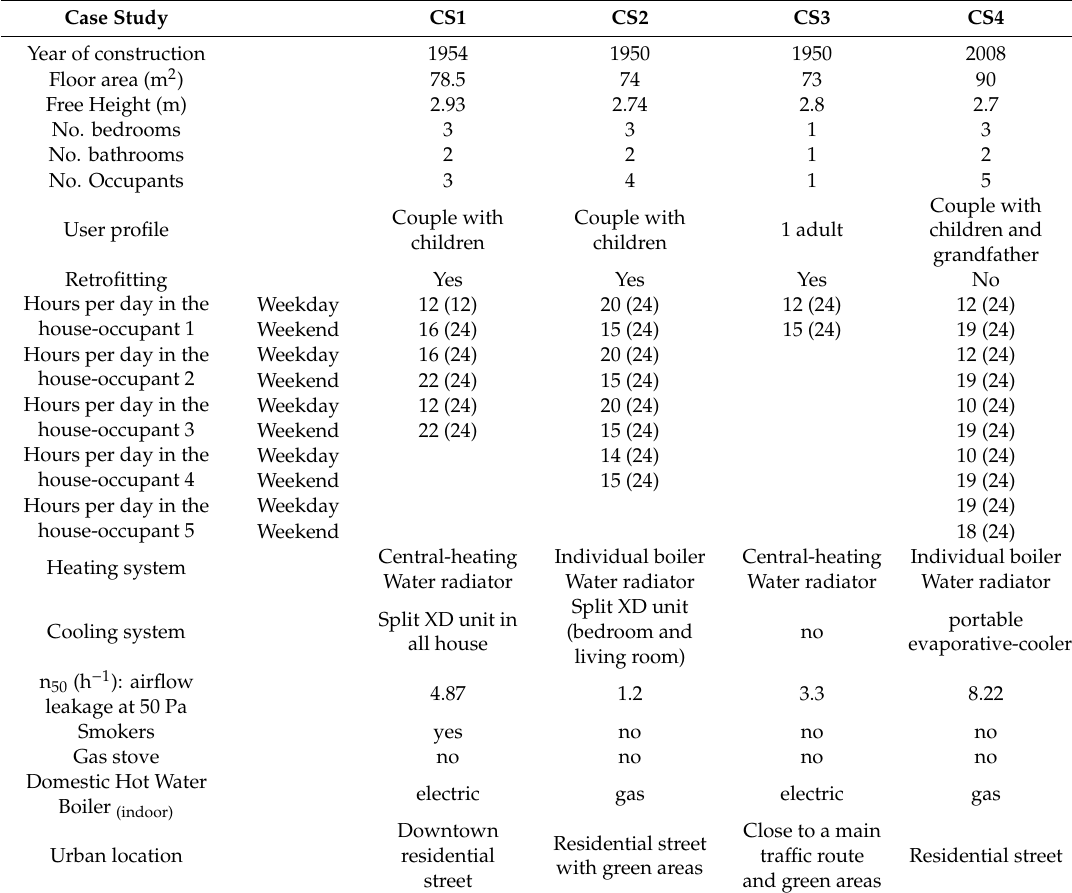
Table 2. Characteristics of the dwellings in the study sample (numbers in brackets represents any changes during